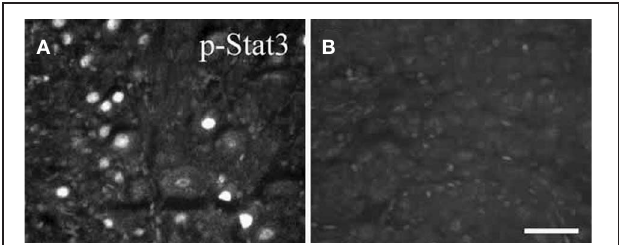
FIGURE 4 | Phospho-STAT3 immunostaining in sections of SCG after axotomy. Forty eight hours after unilateral axotomy, phospho-STAT3 immunostaining was seen in sections of the ipsilateral SCG from wild type (A) , but not from gp130 DBHcre (B) , mice. Scale bar = 50 μ m. The figure is from Habecker et al.